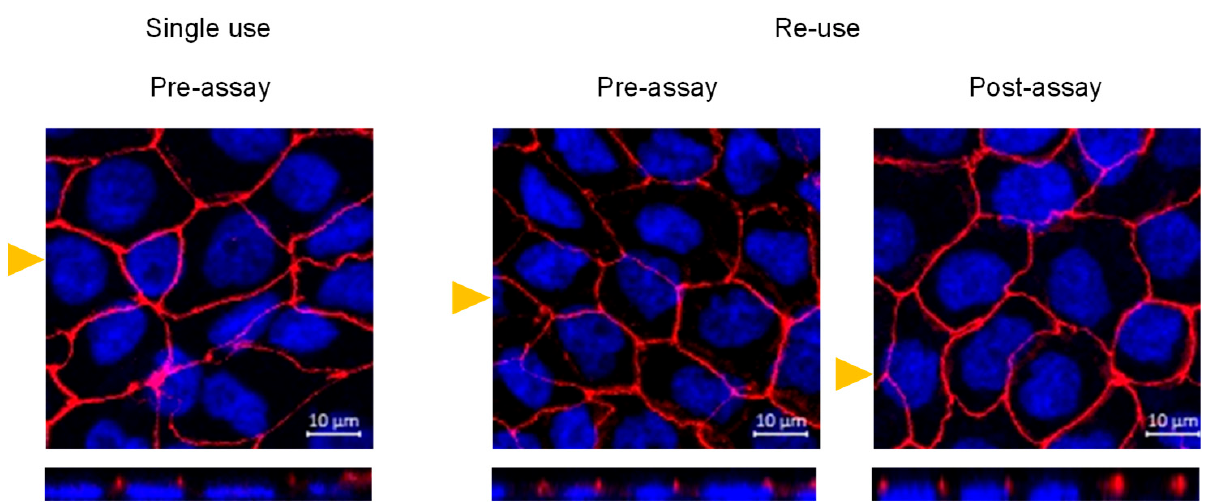
Figure 7. Staining of ZO-1 (red) and nuclei (blue) for Caco-2 monolayers at day 28 post-seeding. In the left plots, the monolayer was not used in permeability assays, in the middle plots the monolayer was previously used on days 22 and 25 and maintained in fresh media until day 28, and the right plots correspond to cell monolayer immediately after a permeability assay on day 28 (after being previously used on days 22 and 25). The lower plots correspond to the z-stacks at the cross section, indicated by the respective yellow triangle.